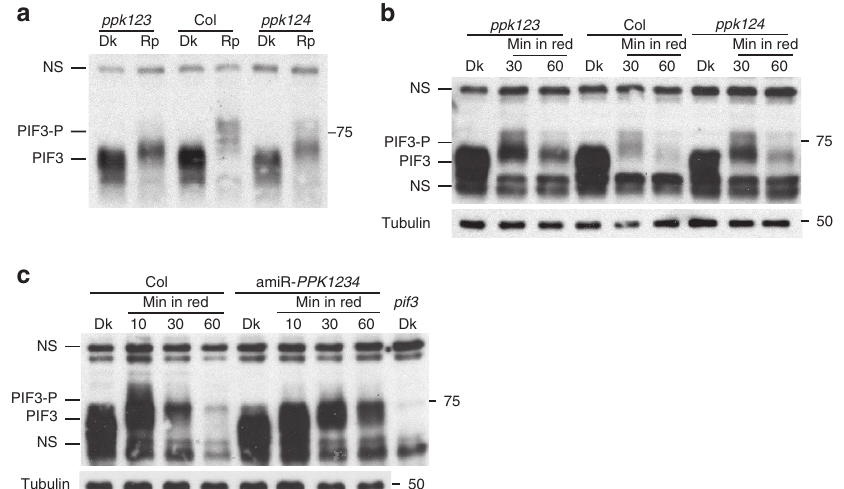
Figure 2 | PPKs are collectively necessary for light-induced PIF3 phosphorylation and degradation in vivo . Both light-induced phosphorylation and degradation of endogenous PIF3 are reduced in higher order ppk mutants. ( a ) Rapid mobility shift (phosphorylation) and ( b ) subsequent degradation in ppk1ppk2ppk3 ( ppk123 ) and ppk1ppk2ppk4 ( ppk124 ) triple mutants compared to wild-type (Col) in response to light. ( c ) Phosphorylation and degradation in artificial microRNA PPK1PPK2PPK3PPK4 (amiR- PPK1234 ) quadruple-knockdown mutant. Dark-grown (Dk) seedlings were irradiated with red light for 10min ( a , Rp), or the period indicated ( b , c ) before protein extraction and immunoblot analysis using anti-PIF3 antibodies. PIF3-P: phosphorylated PIF3; NS: nonspecific